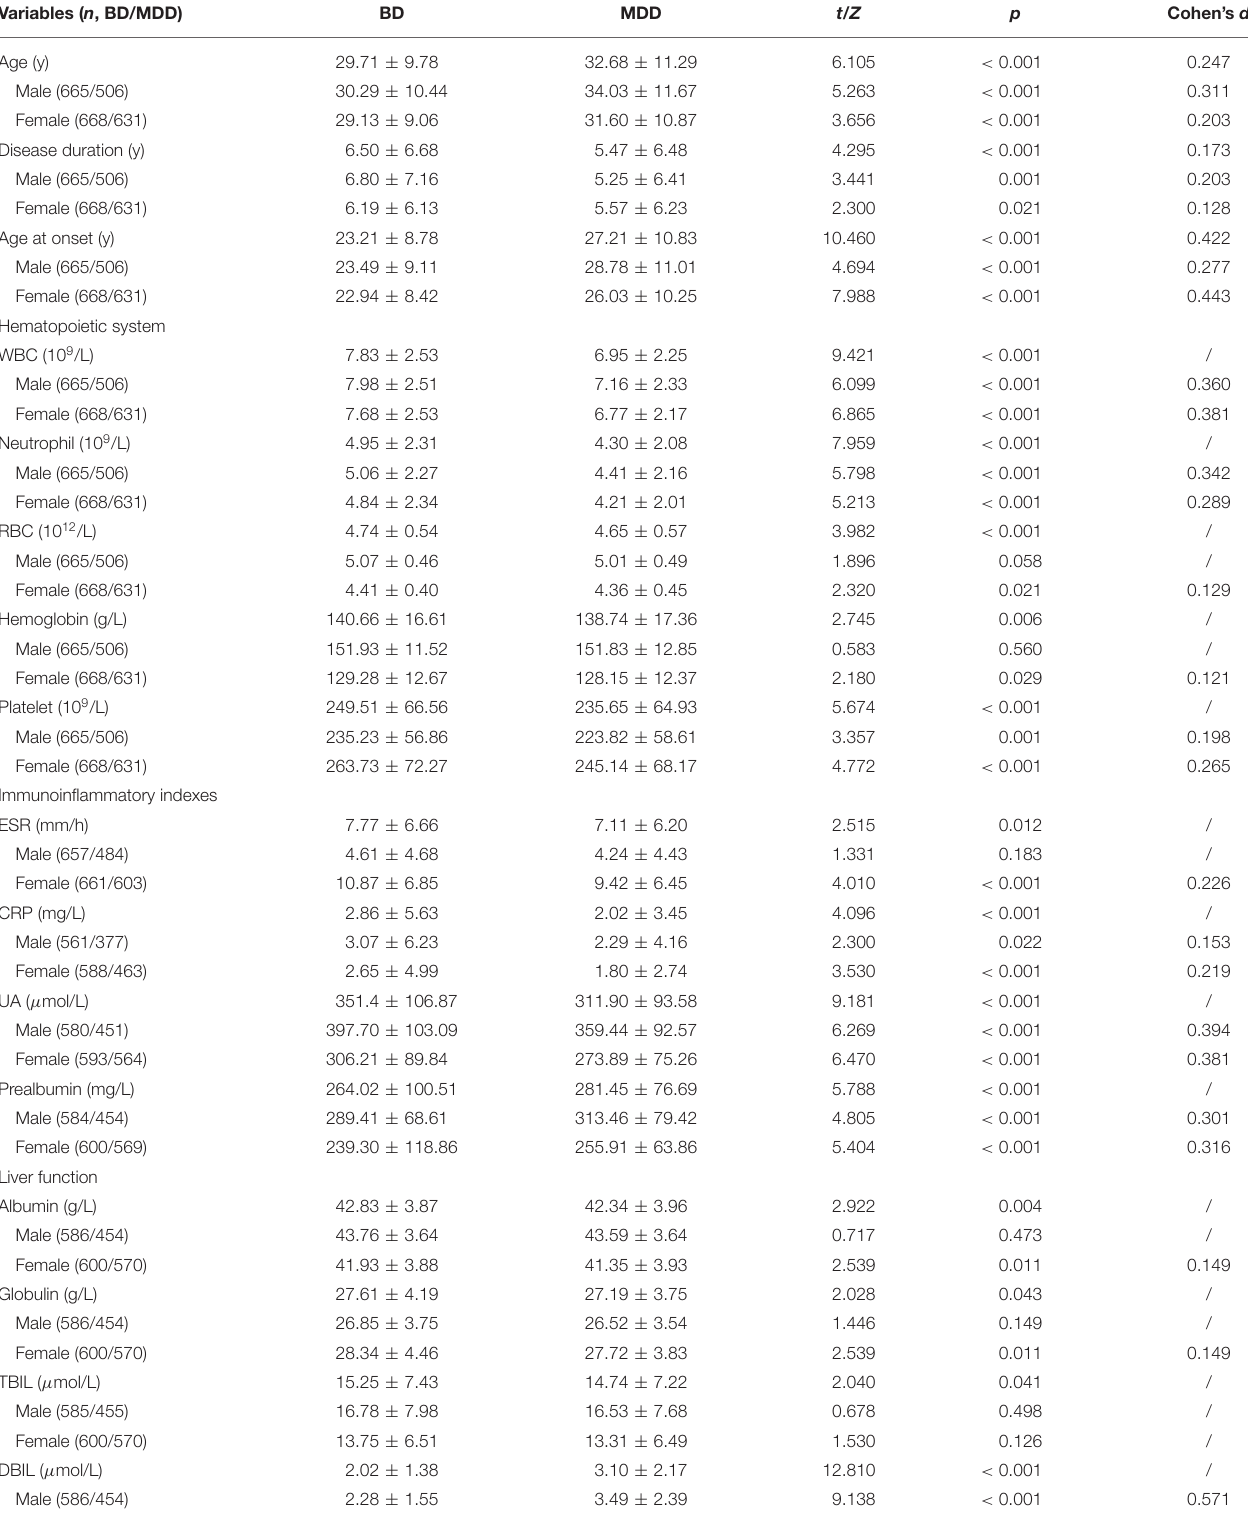
TABLE 1 | Comparison between BD and MDD groups in the gender subgroup. Variables ( n ,